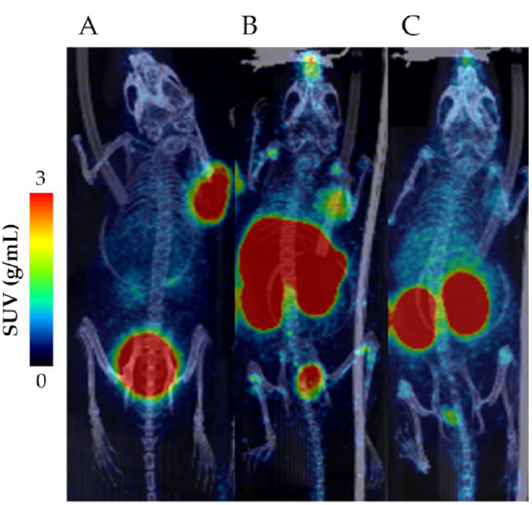
Figure 4. PET/CT imaging in U87.hCXCR4 tumor-bearing mice. MIP image (50–60 min